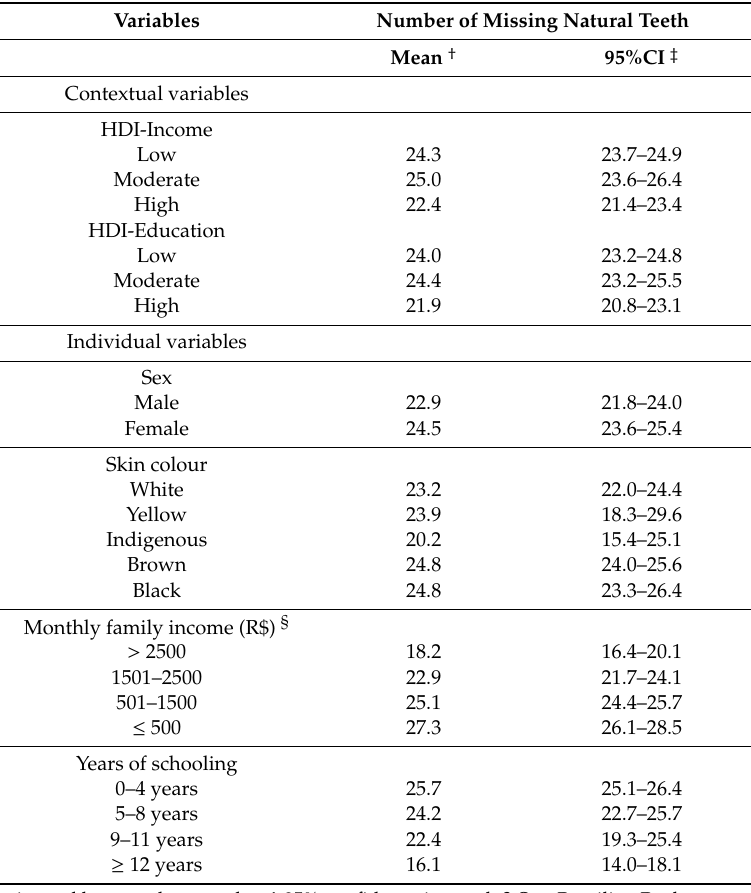
Table 1. Mean of number of missing natural teeth according to contextual factors and individual characteristics among elderly